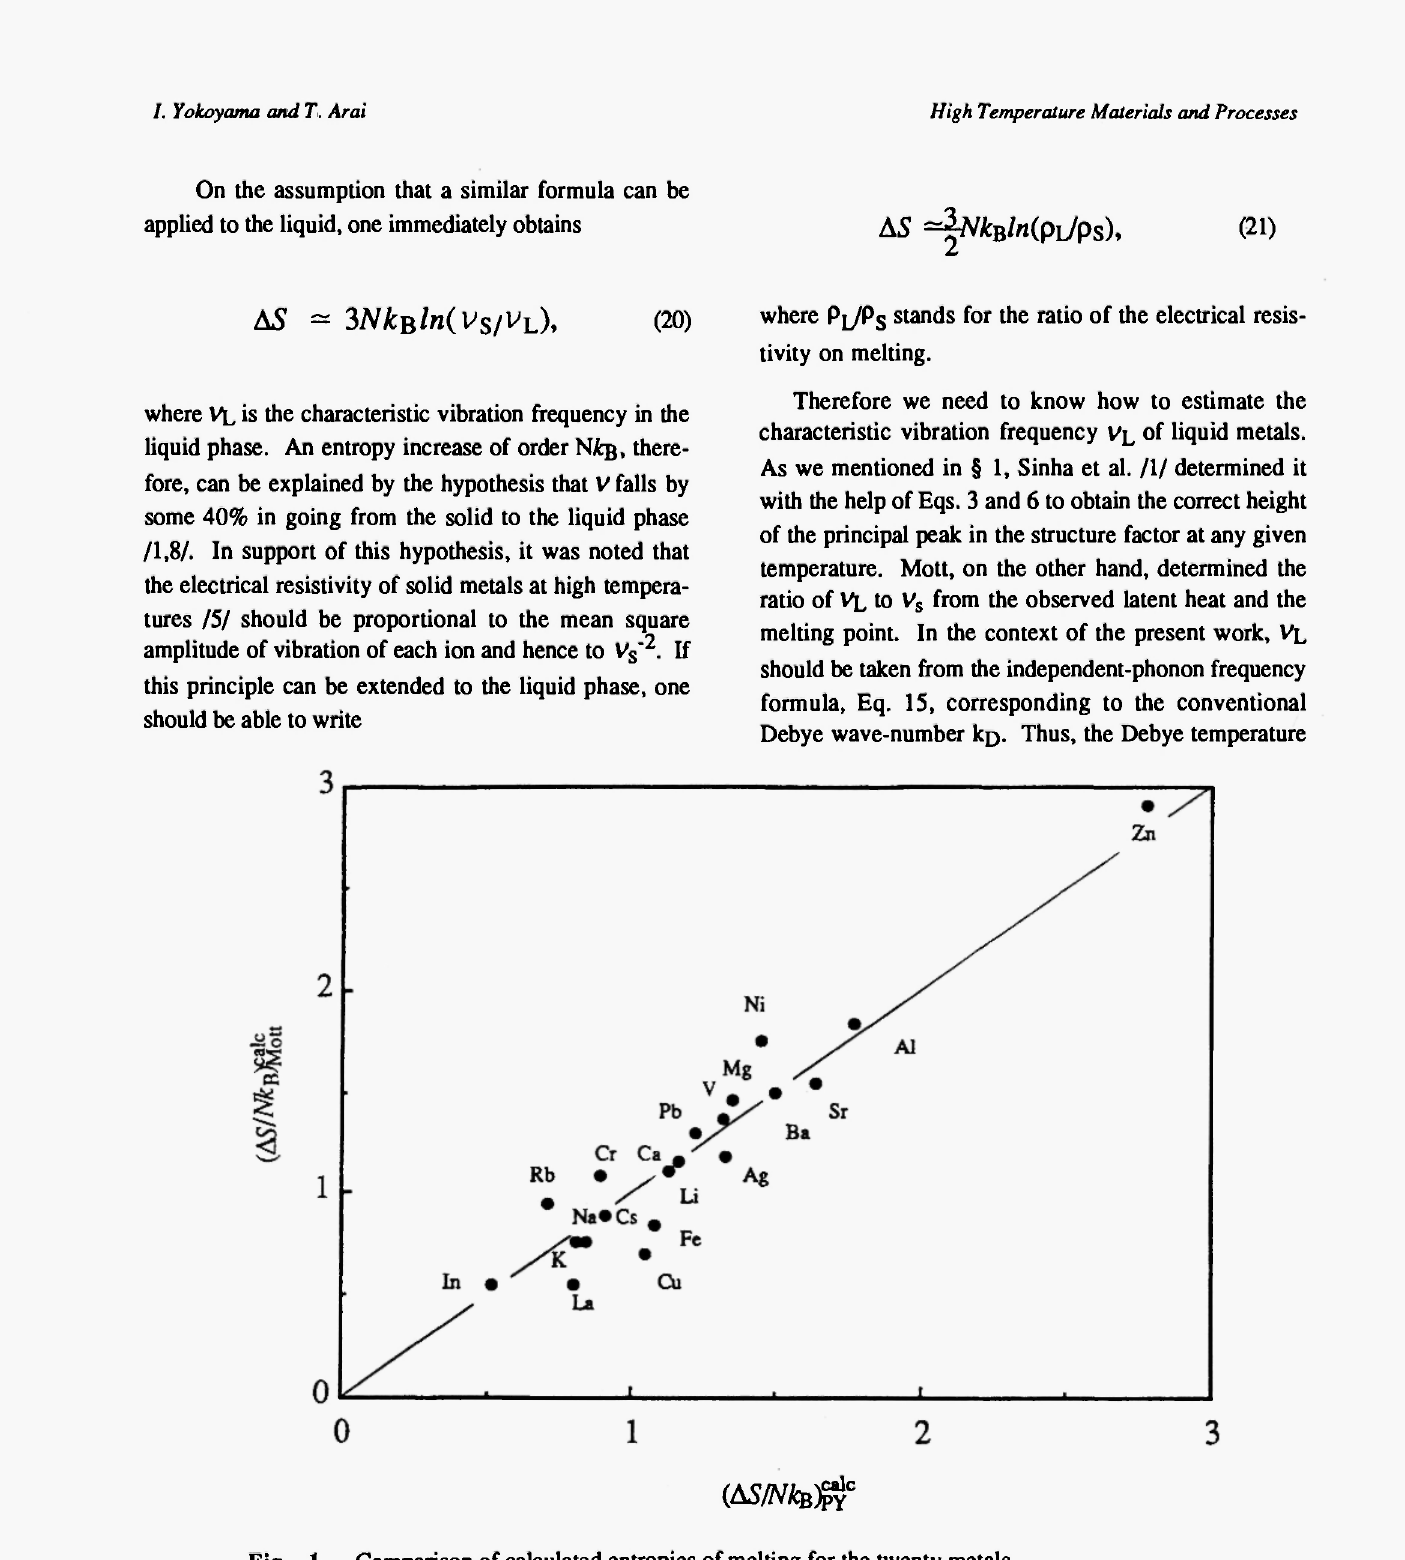
Fig. 1 Comparison of calculated entropies of melting for the twenty metals. (AS/N* B) C PY C : calculated from Eqs. 17 and 18, (AS/N* B) Mott calculated from Eq. 20.